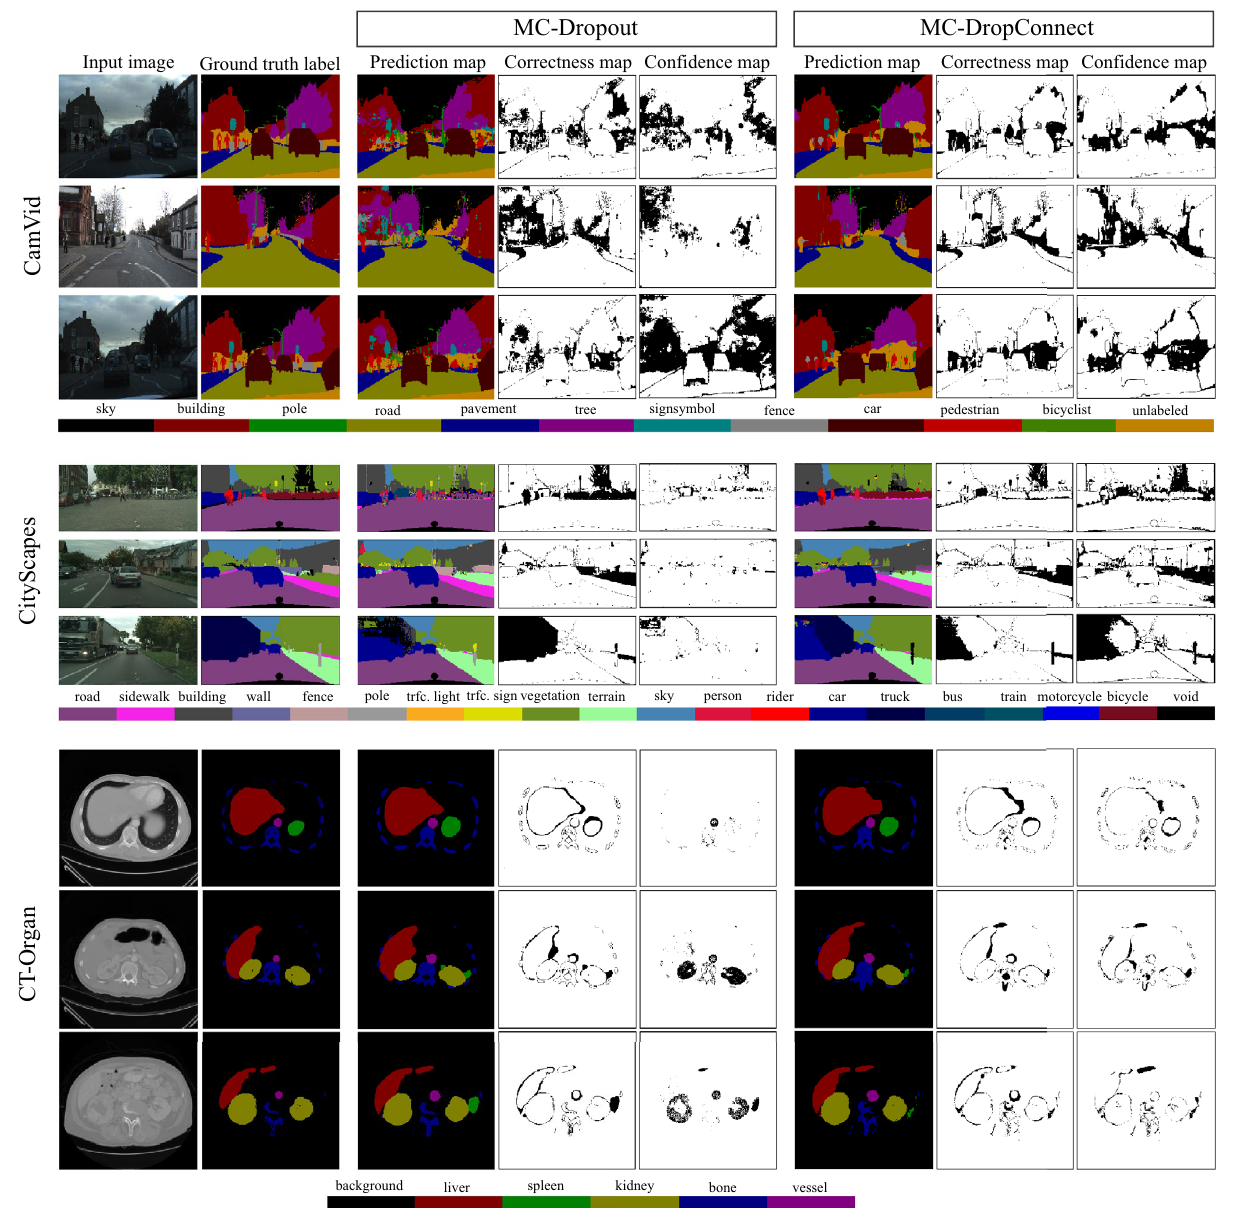
Figure 7. Qualitative results for semantic segmentation and uncertainty estimates on CamVid, CityScapes, and CT-Organ datasets. Each row depicts a single sample and includes the input image with ground truth, prediction, correctness, and confidence (using the mutual information metric) maps for both MC-Dropout and MC-DropConnect. Correctness map is the binary map that shows the correct and incorrect predictions. Confidence map is the thresholded map of uncertainty values computed over all classes. In all cases, the threshold is set manually to the one that achieves the highest UA. Correct and certain regions are respectively shown in white color in the correctness and confidence